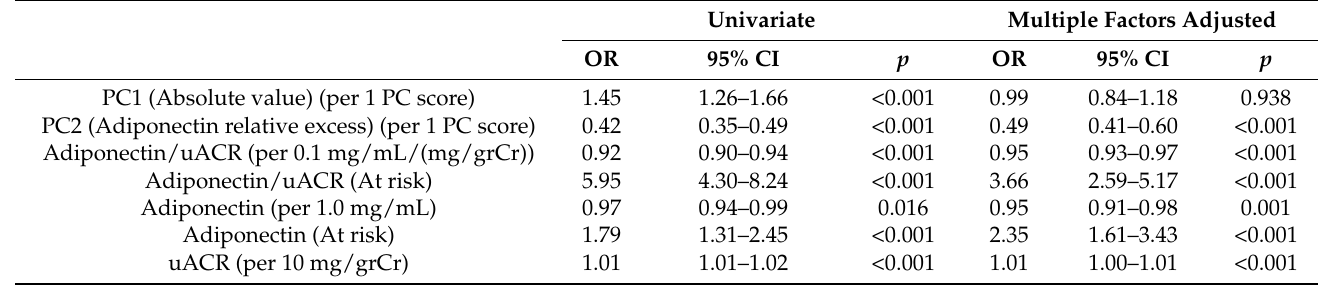
Table 3. Association of serum adiponectin concentration with type 2 diabetes, taking into account the